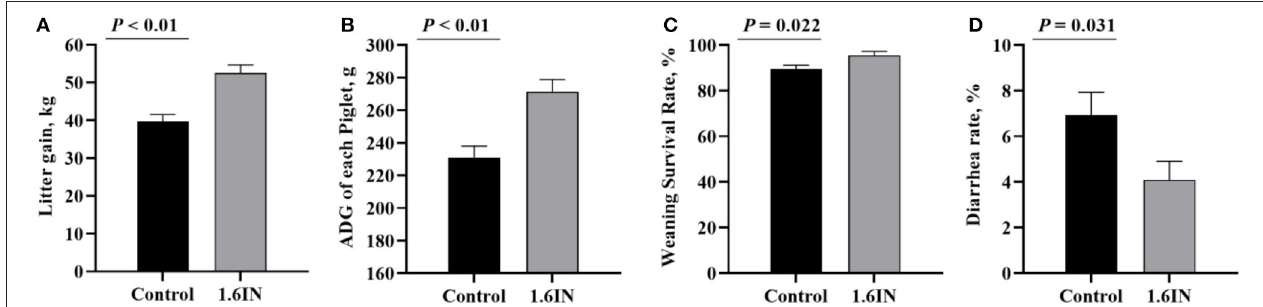
FIGURE 4 | Effects of dietary inulin on the piglet performance during lactation. (A) litter gain at weaning; (B) average daily gain (ADG) of each piglet; (C) survival rate at weaning; (D) diarrhea rate during lactation. Significance was analyzed by an unpaired t -test.